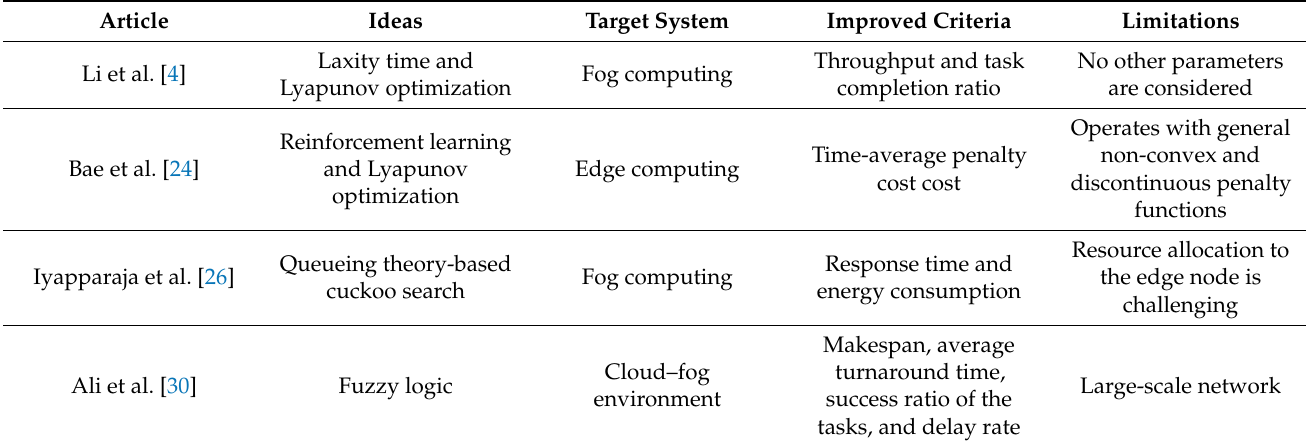
Table 1. Related work on resource allocation in different